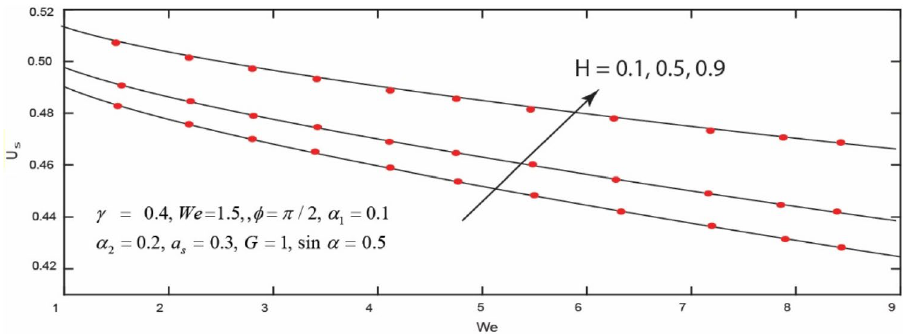
Figure 8. Impact of H on organisms swimming speed.